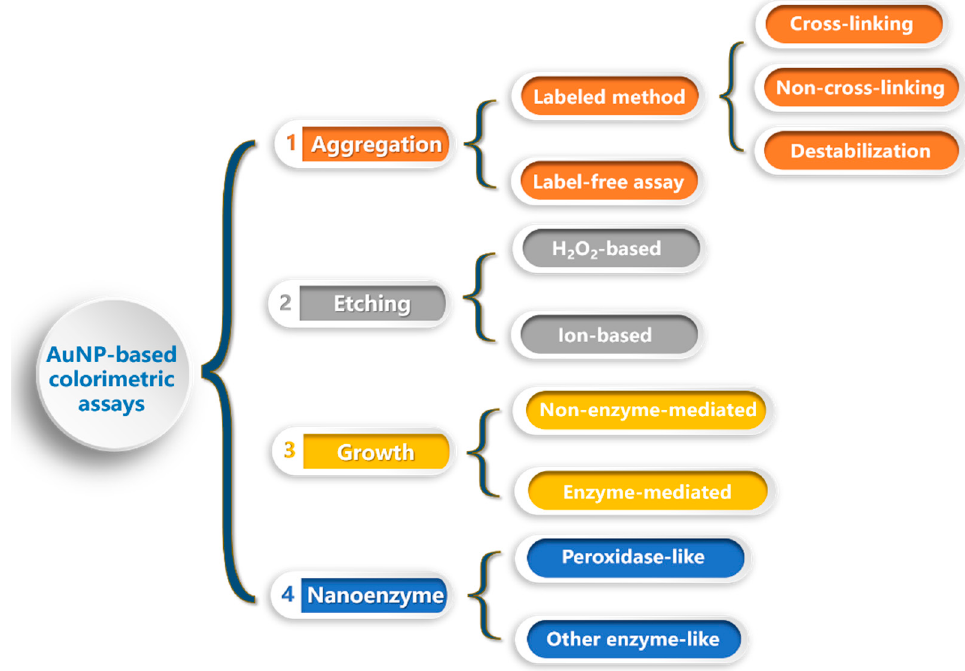
Figure 1. The summary of di ff erent types of gold nanomaterial-based colorimetric sensors.